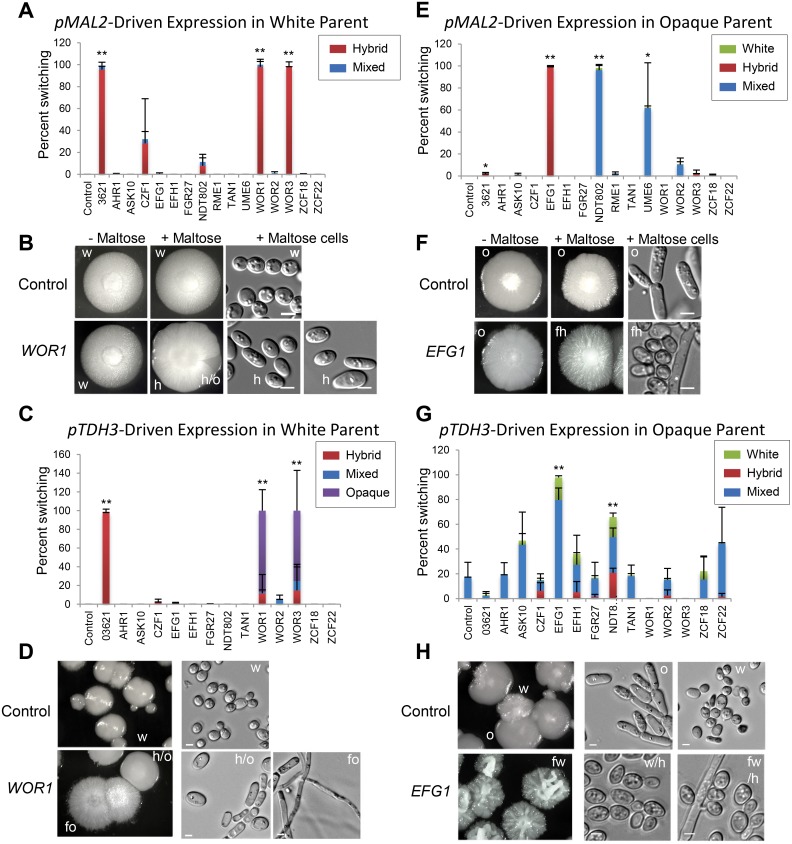
Analysis of C. tropicalis cells expressing transcription factors under the control of the regulatable MAL2 or constitutive TDH3 promoters.Frequency of switching in white parental cells (A) or opaque parental cells (E) upon pMAL2-mediated transcription factor induction (growth on Spider+Maltose medium). * indicates p <0.05, ** indicates p < 0.01 (Student’s t-test). Phenotypes of colonies from white parents (B) or opaque parents (F) cultured on non-inducing (-Maltose) or inducing (+Maltose) medium at 30°C for 7 days. Cells taken from colonies grown on inducing medium are also shown. Frequency of phenotypic switching in white parental cells (C) or opaque parental cells (G) upon transformation with transcription factors under pTDH3 control. ** indicates p < 0.01 (Student’s t-test). Colony morphology (left) and cell morphology (right) from white parental cells (D) or opaque parental cells (H) transformed with the indicated transcription factor under pTDH3 control and grown on Spider medium at 30°C for 7 days. Phenotypes are indicated by “o” (opaque), “h” (hybrid), “w” (white), “fo” (filamentous opaque), “h/o” (hybrid/opaque), “fw” (filamentous white) and “fh” (filamentous hybrid). “Mix” refers to a mixture of phenotypes. Scale bars = 5 μm.